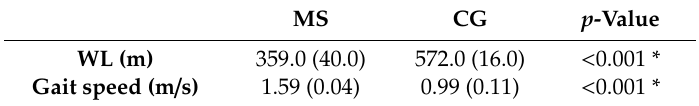
Table 5. Mean (standard deviation) related to the walking length index and the gait speed. MS CG p -Value WL (m) 359.0 (40.0) 572.0 (16.0) < 0.001 * * Stands for statistical di ff erence.